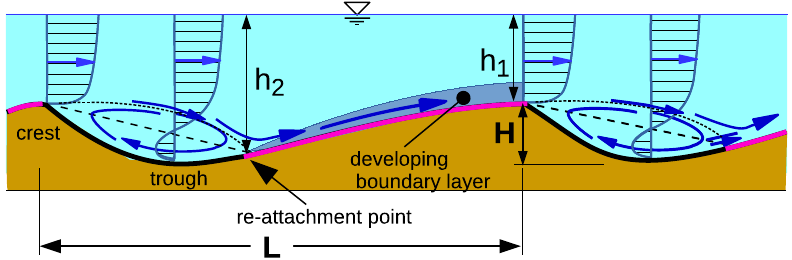
Figure 1. Definitions of dimensions and and characteristic parts of ripples with highlighted devel- oping boundary layer (H = ripple height, L = ripple length, h 1 = water depth at reattachment point, h 2 = water depth at the